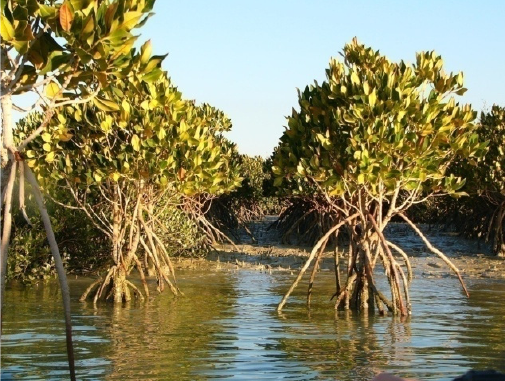
Figure 7: Mangrove tree in coastal